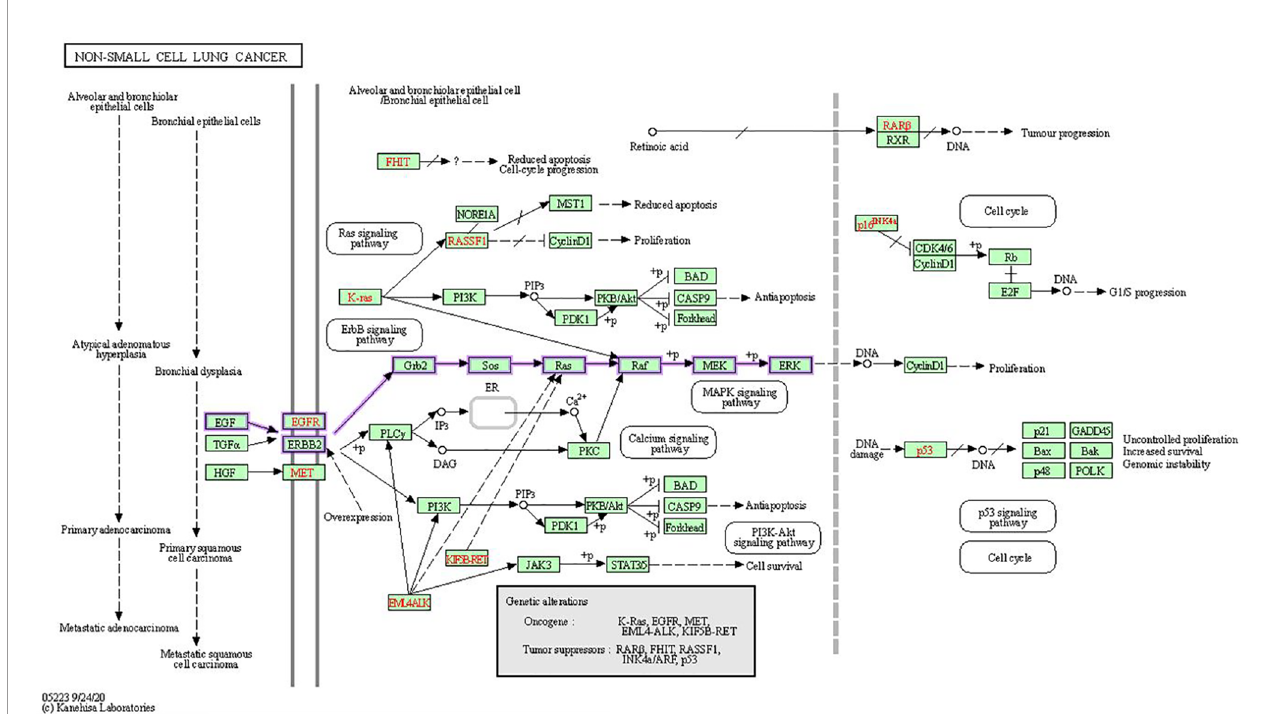
FIGURE 4 | In NSCLC, oncogenes including EGFR, KRAS, and EML4-ALK are activated, while tumor-suppressor genes including RAR-beta, RASSF1, p16INK4a and p53 are inactivated. In the KEGG MAPK signaling network, the Ras/Raf/MEK/ERK signaling pathway is emphasized